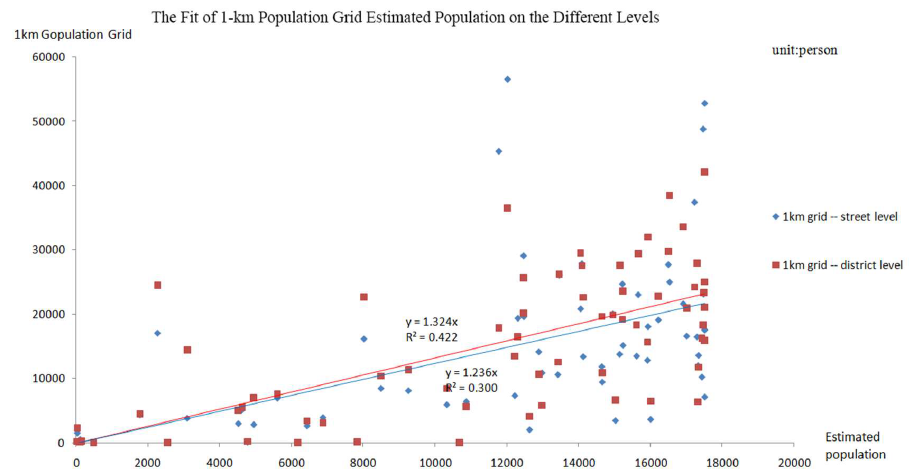
Figure 12. The Correlation between the Grid Population Data set and the Estimated Population.